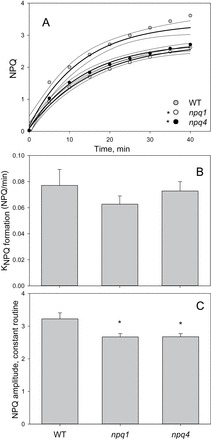
(A) Onset of NPQ formation over a constant 1500 μmol m–2 s–1 light routine, illustrated in Fig. 1. Grey circles indicate WT, white npq1, and black npq4 Arabidopsis leaves. The darker lines indicate regression fit curves {exponential rise to maximum, single, three parameter; f=y
0+a[1–exp(–bx)]}, and the lighter lines represent 95% confidence intervals, all plotted using SigmaPlot12 (Systat Software, Inc.). (B) Rate constant for NPQ formation, obtained via the equation generated from the regression fit curve. Error bars show the standard deviation. (C) Amplitude of NPQ formation derived from the equation for the fitting of the regression curve. Error bars illustrate the SD. A single asterisk is used to signify this significant difference between mutants and WT plants, with a double asterisk representing a significant difference between npq1 and npq4 plants (P<0.05).